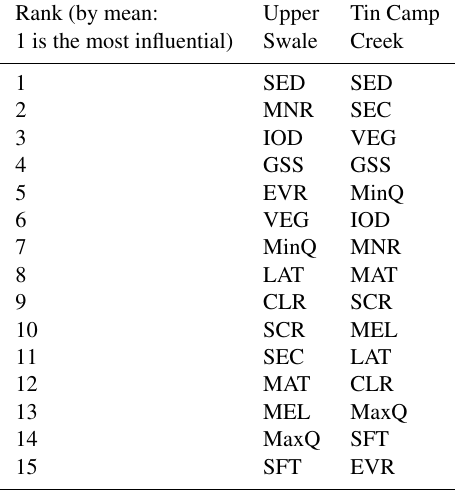
Table 3. Parameters ranked by means for each catchment from the aggregated scores for all elementary effects. SED is the sediment transport formula; MEL is the maximum erode limit; CLR is the in channel lateral erosion rate; LAT is the lateral erosion rate; VEG is the vegetation critical shear stress; MAT is the grass maturity rate; SCR is the soil creep rate; SFT is the slope failure threshold; IOD is the in/out difference; MinQ is the minimum Q value; MaxQ is the maximum Q value; SEC is the slope for edge cells; EVR is the evaporation rate; MNR is the Manning n roughness coefficient; and GSS is the grain size set.